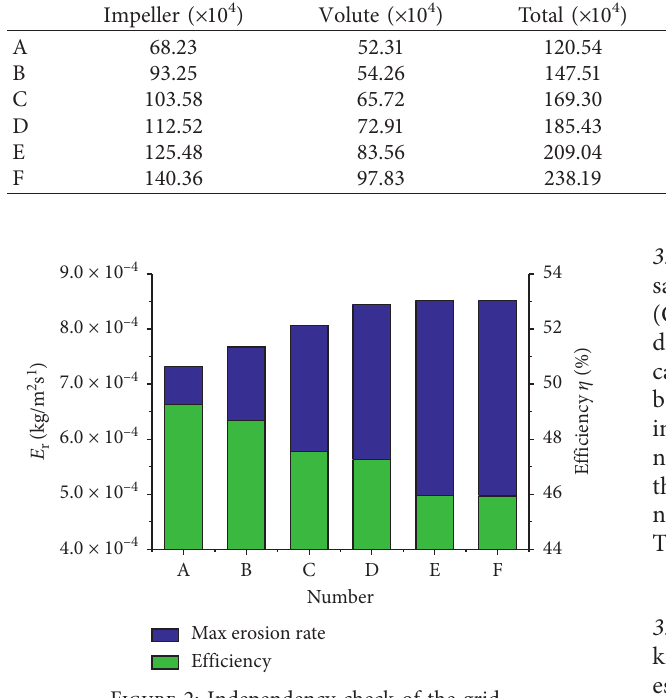
Figure 2: Independency check of the grid.